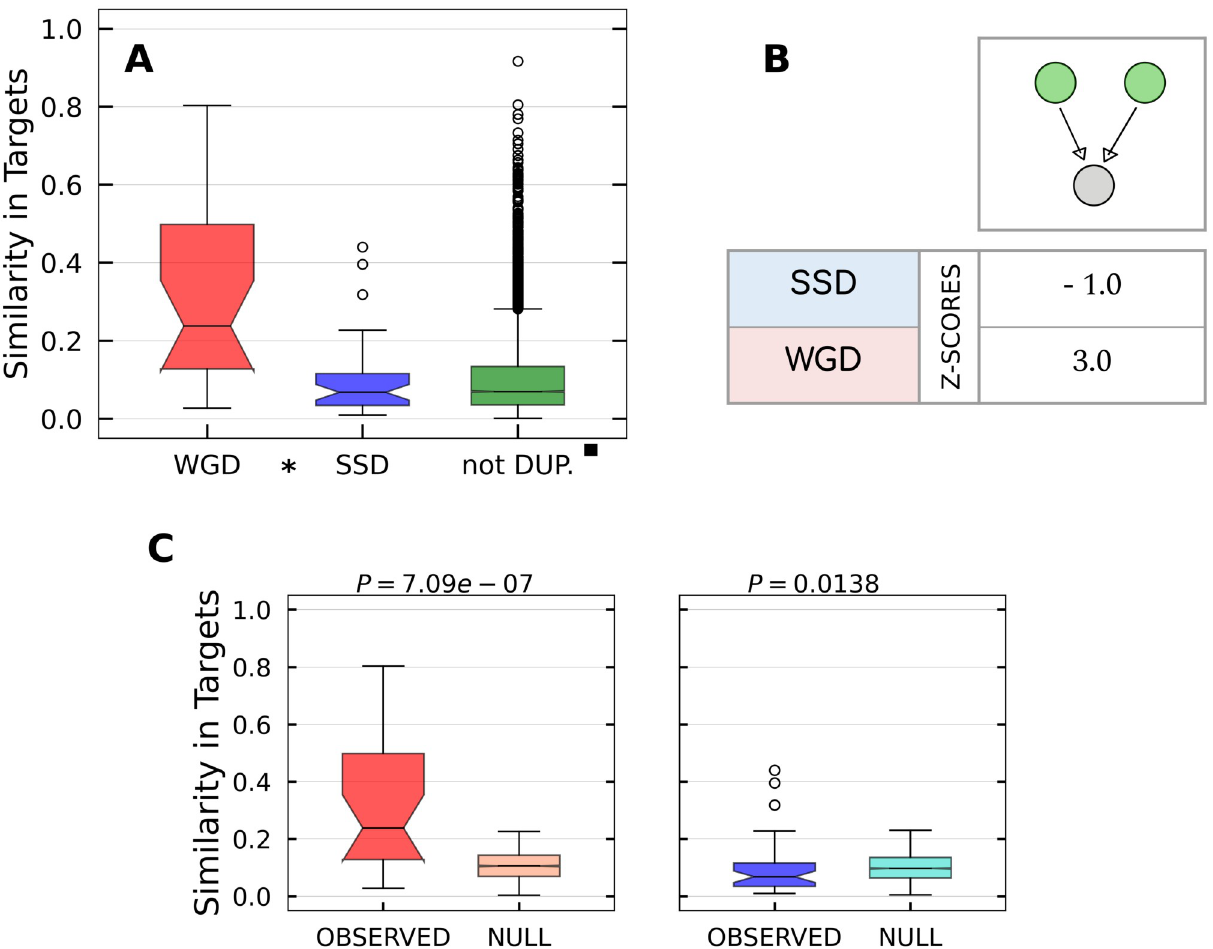
Fig 5. Transcriptional V motifs. (A) Similarity distributions for WGD, SSD and not duplicated TF couples in the ENCODE network. As indicated by the presence of the symbols explained in the Materials and methods section, the difference between SSD and not-duplicated distributions is not statistically significant while the comparisons involving the WGD distribution are instead significant. (B) Z-scores measuring the enrichment of the V motif with respect to the null model. (C) Pairwise comparison between each real similarity distribution and the null distribution for the respective duplication